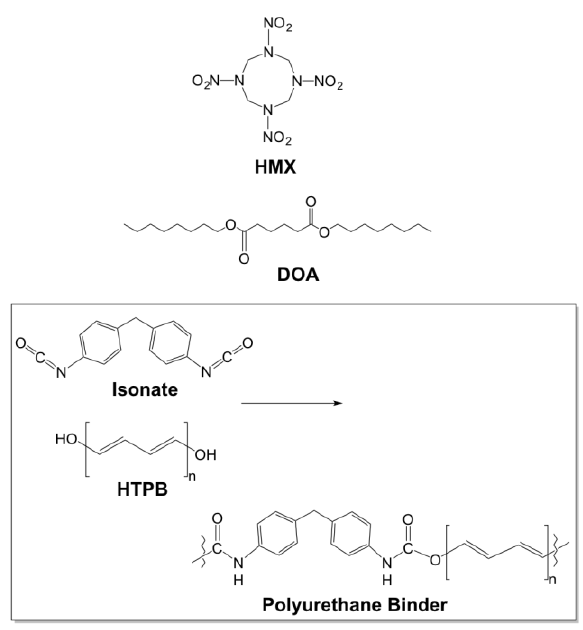
Figure 1. Chemical components of the HMX/HTPB formulation, where HTPB cures with isonate to form the polyurethane binder system surrounding the HMX crystals and DOA performs as a plasticizer. Table 1. HMX formulations prepared and